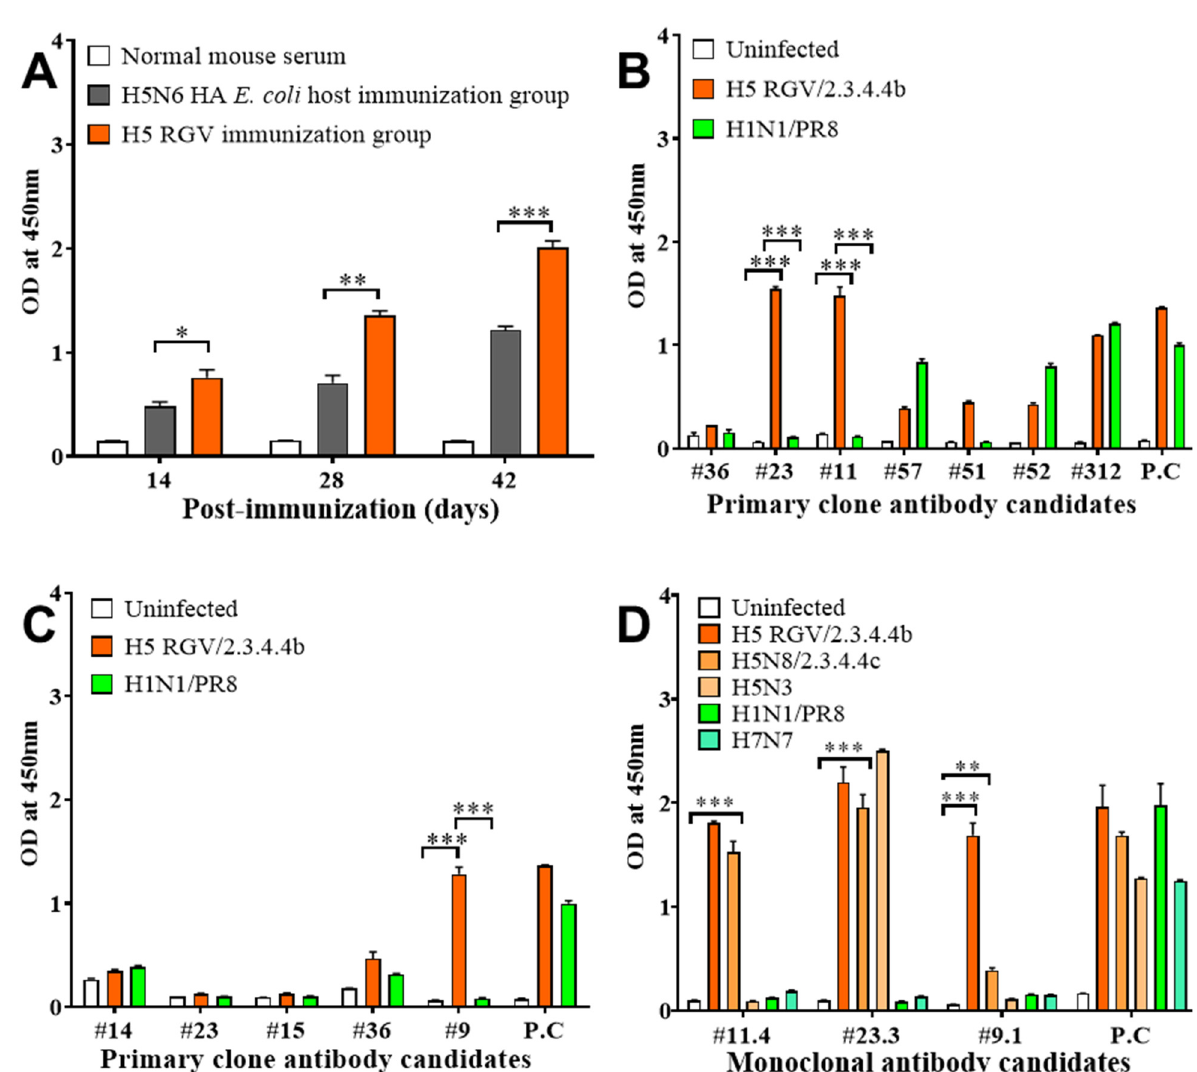
Figure 2. Development of H5-specific antibodies. Mice were immunized with H5 reversed genetic influenza virus (RGV) or recombinant protein three times by footpad injection. ( A ) Mice sera were collected 2 weeks after each immunization for determining the levels of antibody against H5 RGV and other subtypes as determined by indirect enzyme-linked immunosorbent assay (ELISA) in the experimental and control groups. ( B ) Levels of primary clone antibodies for H5 RGV. ( C ) Levels of primary clone antibodies for H5N6 HA recombinant antigen. ( D ) Monoclonal antibodies against several H5 subtypes, H1N1/PR8, and H7N7. The positive control (P.C) is the anti-NP of influenza A virus. ANOVA was used to analyze significant differences between the experimental groups and the control group. *, p < 0.05; **, p < 0.01; ***, p < 0.001.